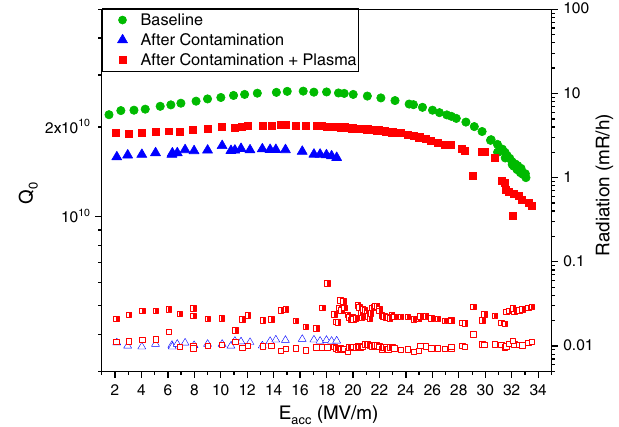
FIG. 9. Quality factor versus accelerating field curves measured on the contaminated cavity and after plasma cleaning. The contaminated cavity (blue triangle) exhibits a degradation in quench field and Q 0 . After plasma processing it exhibits an increase in quality factor (Q 0 ¼ 2 × 10 10 at 16 . 4 MV = m) and a complete recovery in E (the quench field is 33 . 5 MV = m). In acc green is shown the baseline performance of the cavity before contamination. Solid symbols are used to plot the Q 0 vs E acc curve, empty symbols for the radiation detected from the top detector, and half-filled symbols for the bottom radiation detector.